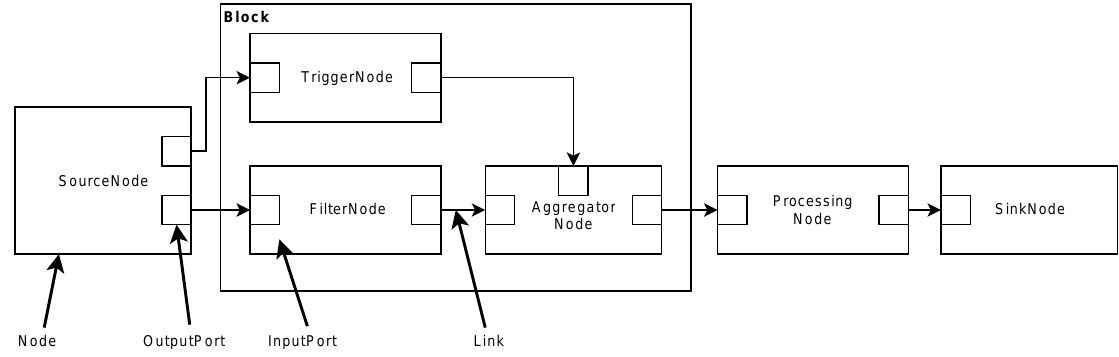
Figure 12. Processing pipeline